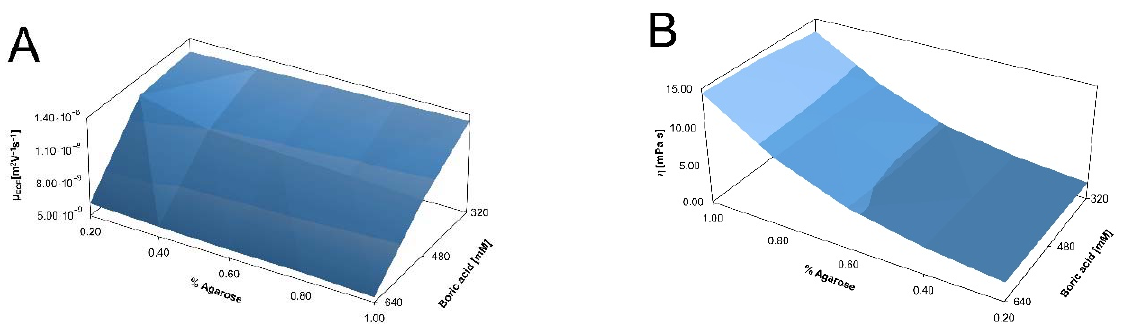
Figure 2. Three ‐ dimensional electroosmotic flow ( μ EOF , panel A ) and viscosity ( η , panel B ) plots of the different agarose ‐ TBE gel